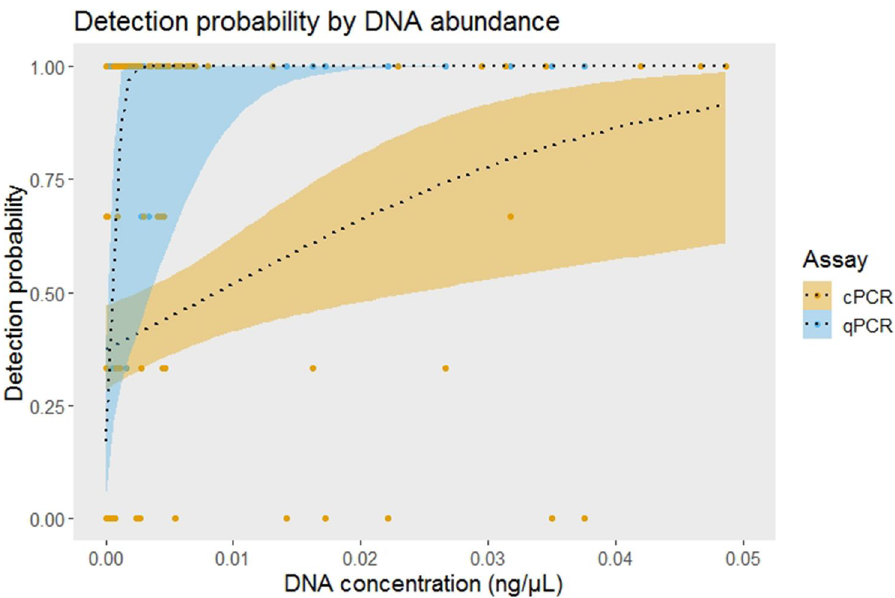
Figure 3. The relationship between the detection probability and DNA concentration for cPCR and qPCR. The dotted lines indicate the fitted regression model and the coloured bands the 95% confidence interval.